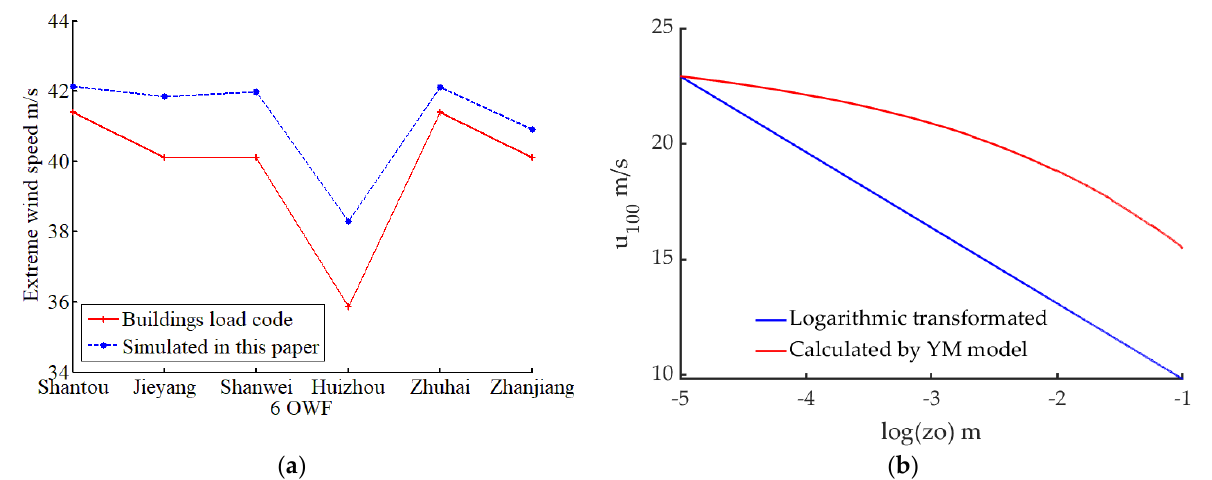
Figure 6. ( a ) Comparison of EWS predicted in this paper with the result from building load code for six OWF under construction; ( b ) the Influence of z 0 on wind speed at hub height from two different calculation method.